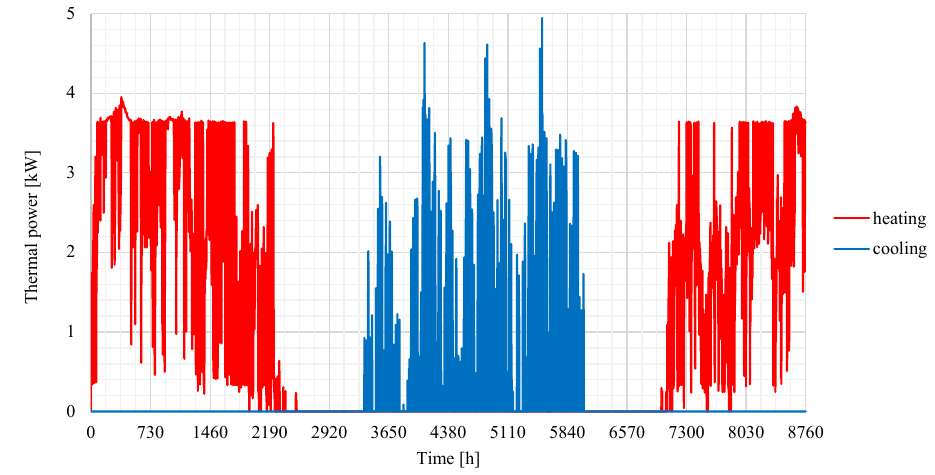
Figure 4. Thermal power demand for space heating and cooling of the building.